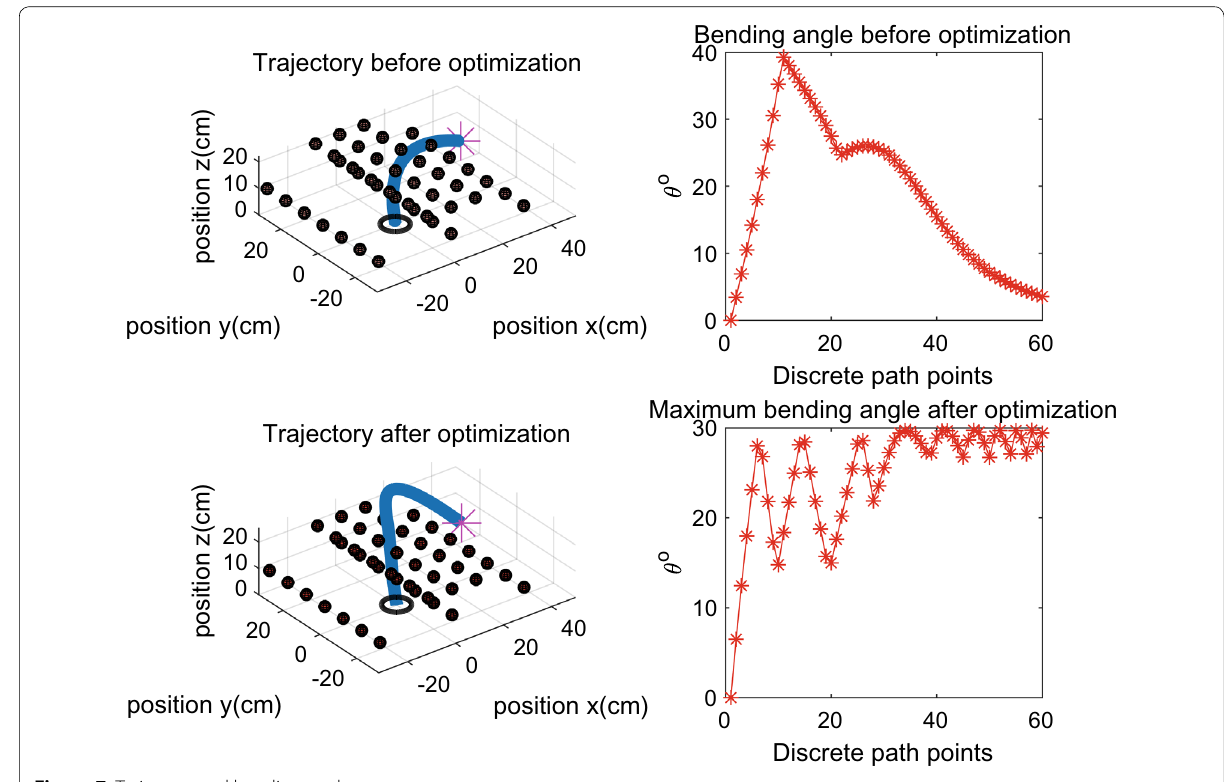
Figure 7 Trajectory and bending